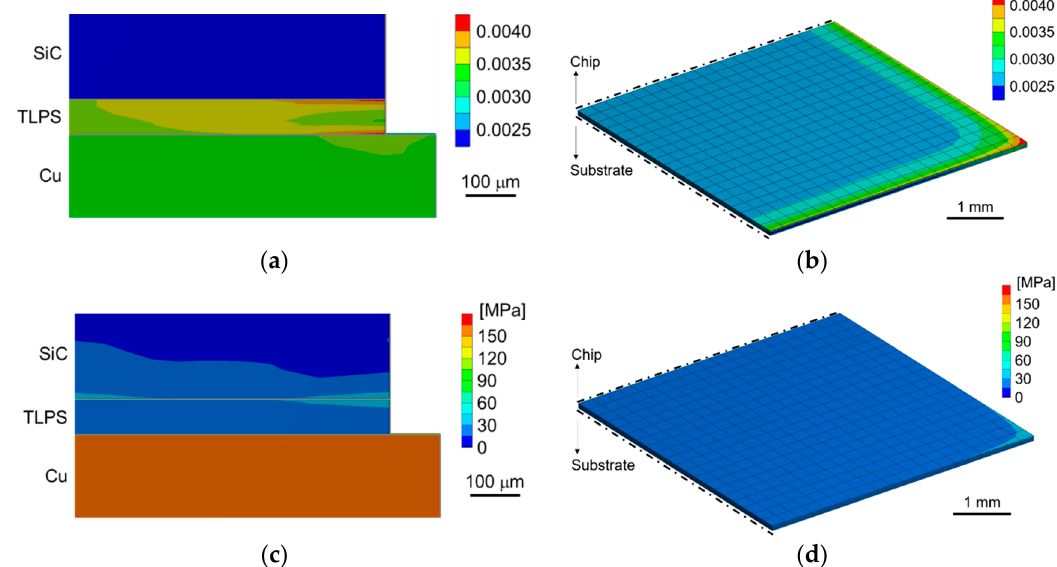
Figure 9. FE simulation results of total strain distribution ( a ) at cross-sections along the diagonal axis of the joint and ( b ) in the transient liquid-phase sintering (TLPS) bonding layer. Simulated Mises stress distribution ( c ) at cross-sections along the diagonal axis of the joint and ( d ) in the TLPS bonding layer at minimum temperature during the thermal cycling.